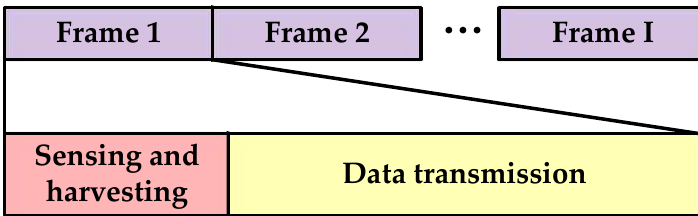
Figure 6. Frame structure of the cognitive sensor network.